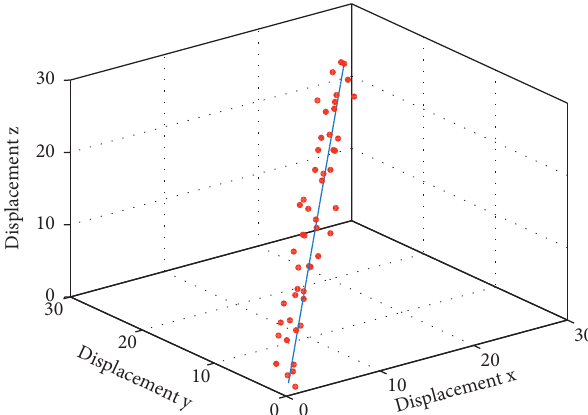
Figure 5: Fitting of the scattered points of the joint trajectory of the virtual walking motion.